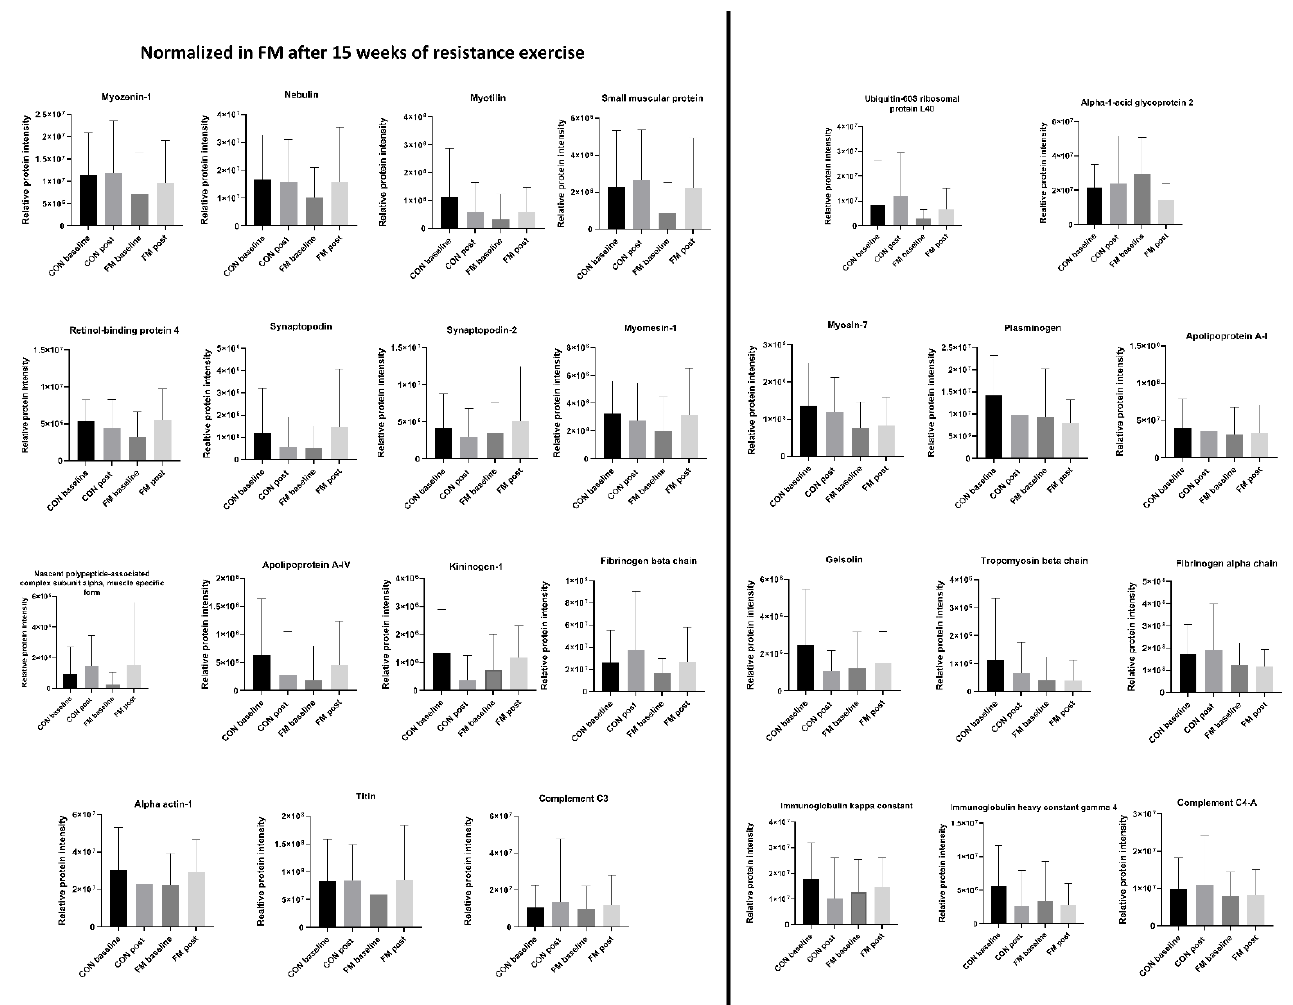
Figure 4. Normalization of proteins post-exercise. Altered relative protein expression levels (mean ± SD) for the 26 significant proteins that were able to discriminate the fibromyalgia (FM) and control (CON) group at baseline. Fifteen proteins were normalized in FM post-exercise.